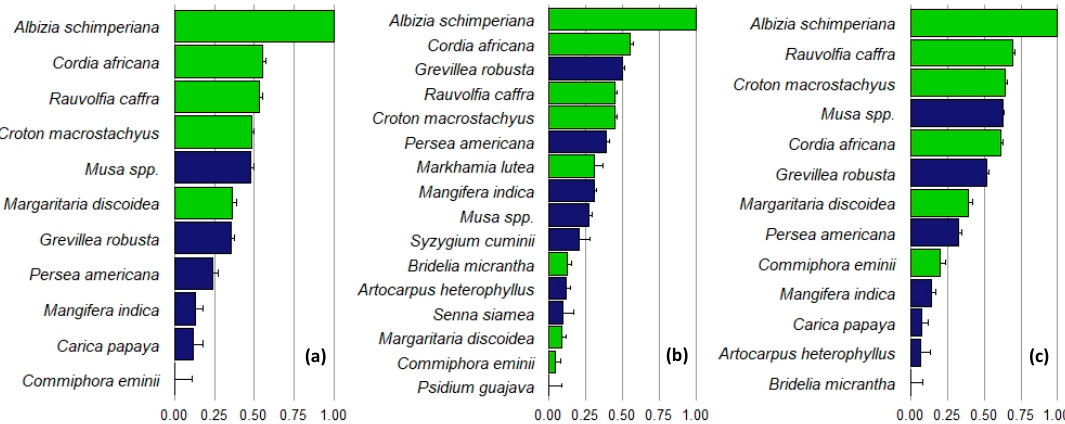
Figure 5. Scores and quasi-standard errors of the tree species ranked according to: ( a ) increase of coffee yield and quality, ( b ) protection from heat, wind and shade provision and ( c ) mulch provision, soil fertility and soil moisture enhancement. Green bars represent indigenous, and dark blue bars exotic tree species.